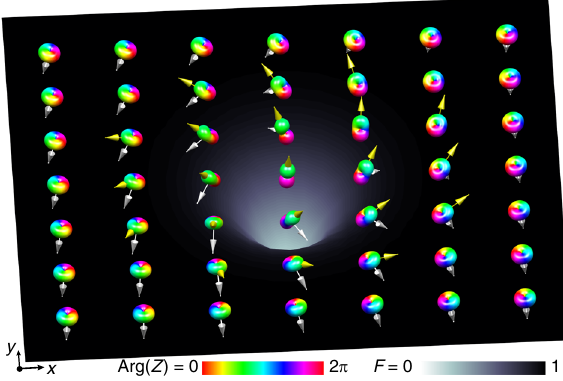
Fig. 1 Numerical simulation of a singly quantised singular SO(3) vortex. The symmetry of the local spinor order parameter is illustrated by a graphical representation of the surface of | Z ( θ , ϕ )| 2 , with the colour indicating P þ 1 Y ð θ ; ϕ Þ ζ Arg( Z ), where Z ð θ ; ϕ Þ ¼ m corresponds to an expansion m ¼(cid:2) 1 1 ; m of the spinor in terms of spherical harmonics Y 1, m ( θ , ϕ ), such that ( θ , ϕ ) de fi ne the local spinor orientation. Outside the vortex core the order parameter reaches the SO(3) symmetric ferromagnetic phase. Inside the core it continuously connects with the nematic order parameter of the polar phase at the vortex line singularity, forming a coherent topological interface. The interpolation of the order parameter across the interface is readily apparent in the vanishing magnitude of the spin vector h ^ F i (silver arrows and background surface) at the vortex line where the polar phase is determined by the ^ d vector (gold arrows) and the phase of the macroscopic condensate wave function. Source data are provided as a Source Data fi